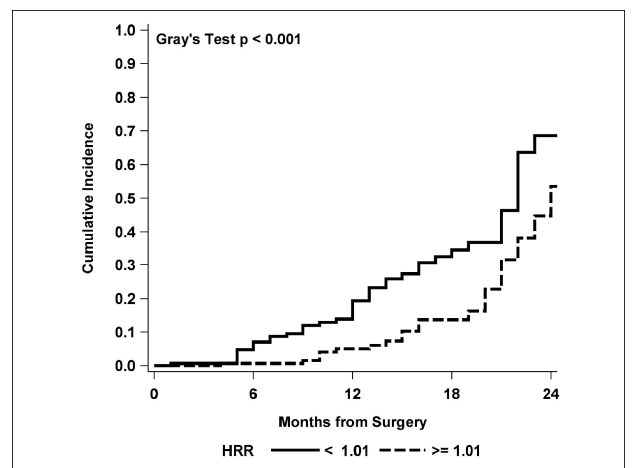
Figure 1. Cumulative incidence functions for relapse by the HRR median cut-off value.